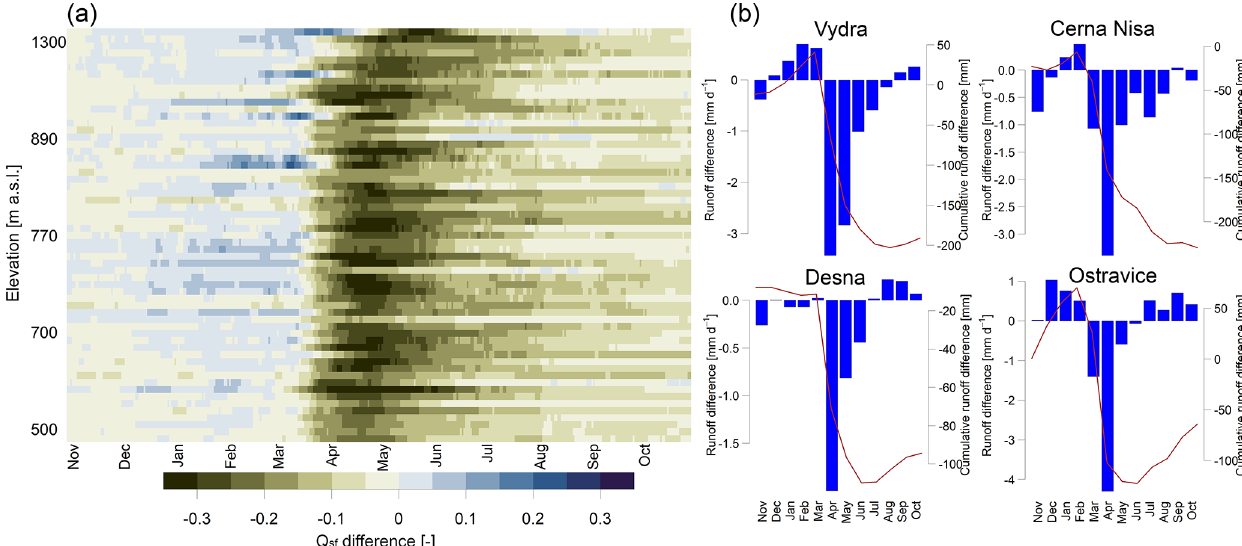
Figure 4. (a) Difference between mean daily Q sf (–) for snow-poor and snow-rich years. Rows represent individual catchments sorted from top to bottom according to mean catchment elevation from highest to lowest ( y axis not to scale); columns represent day of year. (b) Difference between mean monthly runoff (blue bars) and cumulative monthly differences in runoff (red line) for snow-poor and snow- rich years: Vydra (Bohemian Forest), ˇCerná Nisa (Western Sudetes), Desná (Eastern Sudetes), and Ostravice (Western